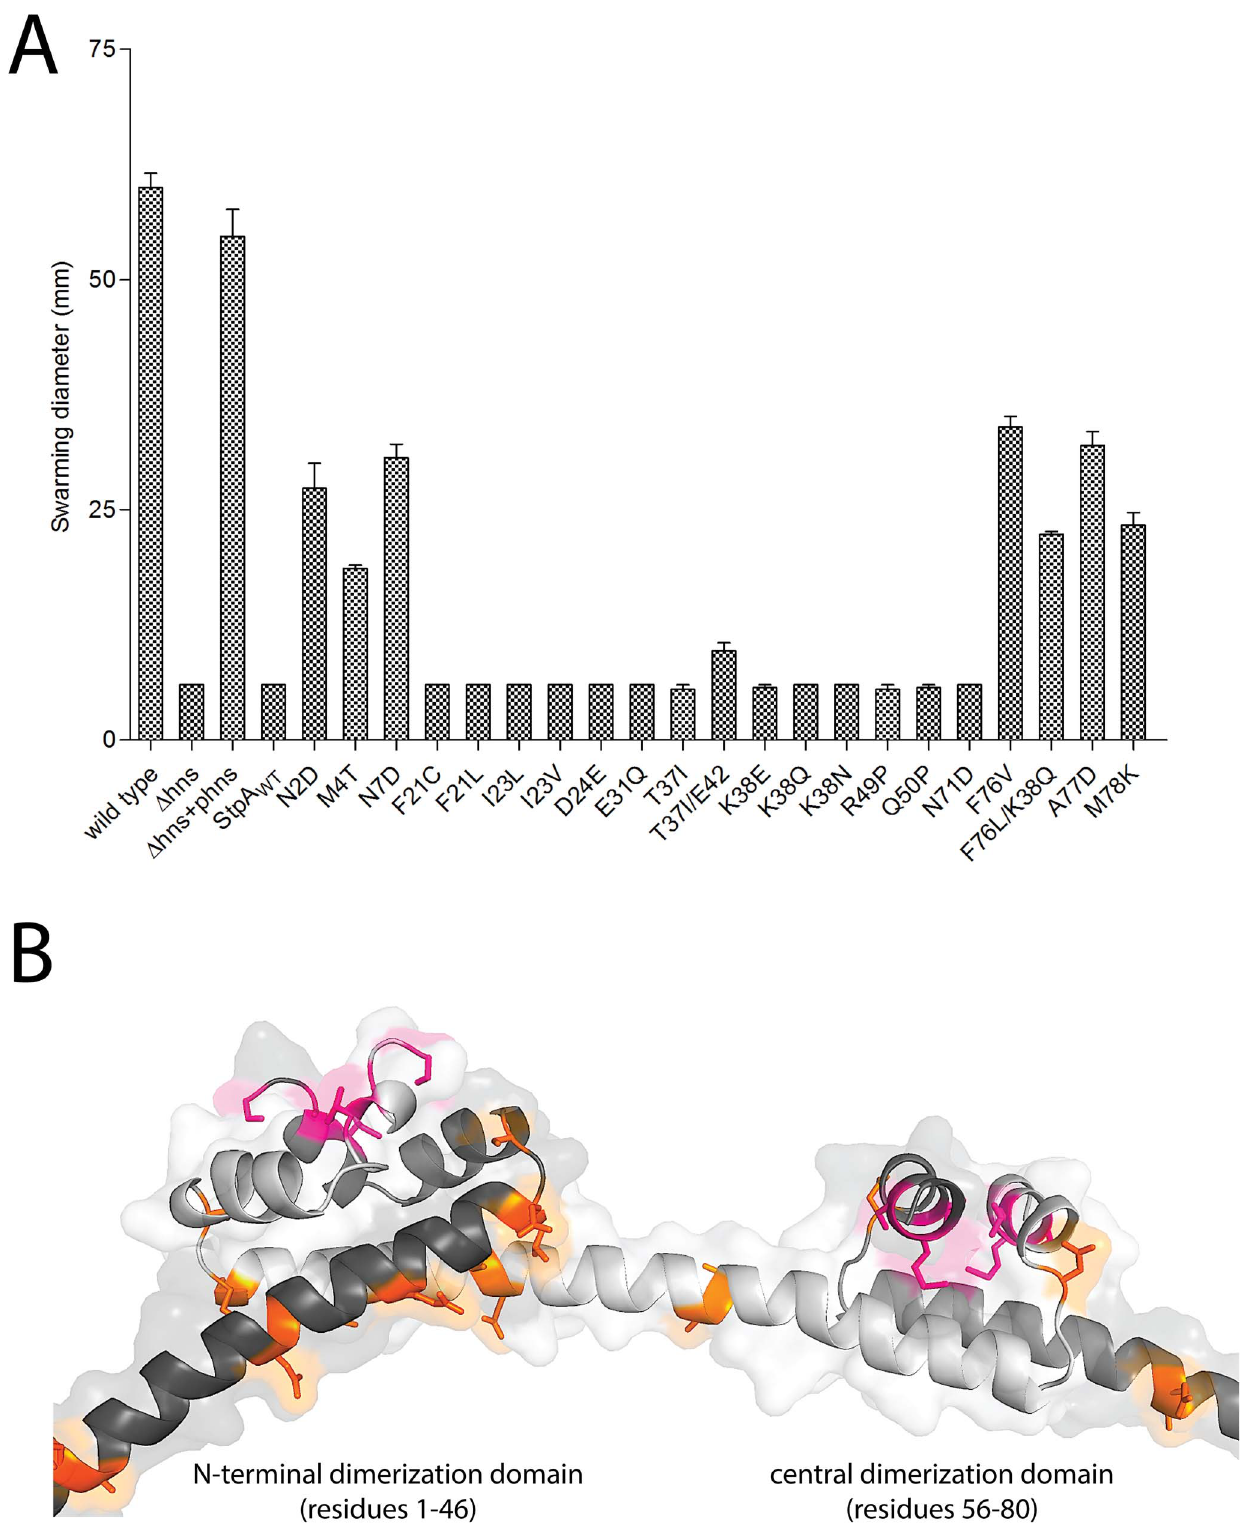
Figure 8. StpA mutants that partially restore the motility phenotype in hns mutants cluster in regions. (A) Swarming motility of the s trains expressing either StpA WT or individual StpA variants were measured on soft agar plates following a 12 hour incubation period at 37 u C. Bars represent the average swarm diameter of three independent experiments and error bars represent the standard error. (B) Location of the StpA mutations mapped on the structure of the H-NS oliomerization domain. Orange residues indicate individual changes that could not impart H-NS functionality upon StpA.